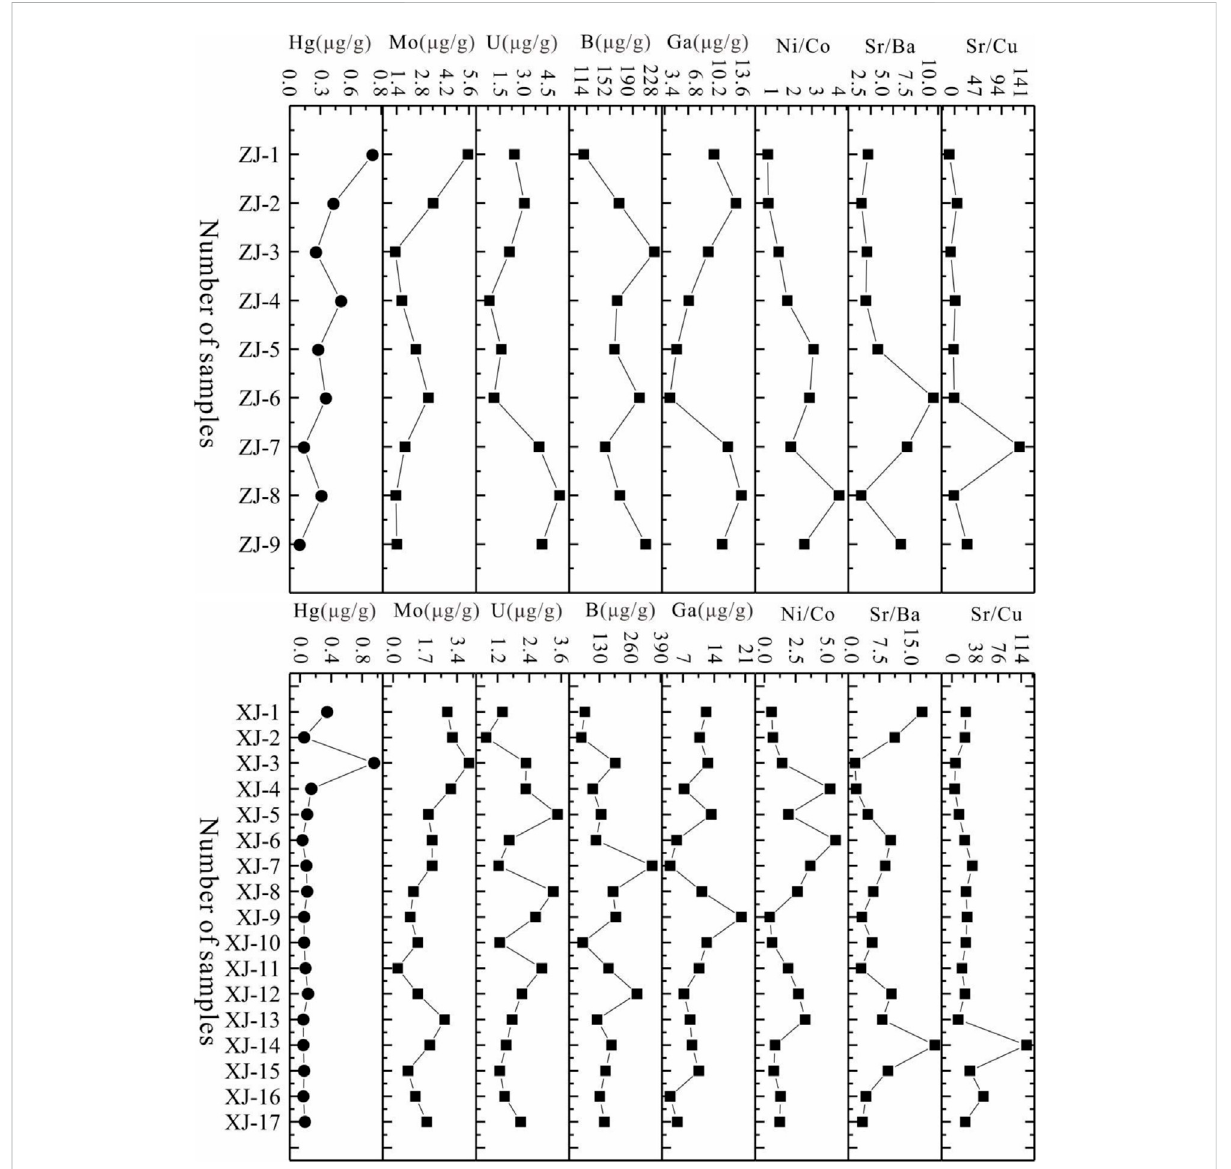
FIGURE 7 The characteristic content distribution of mercury and depositional environment in